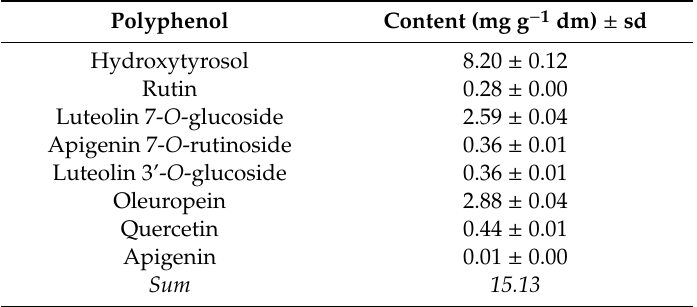
Table 6. Yield of major polyphenolic phytochemicals obtained with La-Gly (5:1), under optimized conditions, at 80 ◦